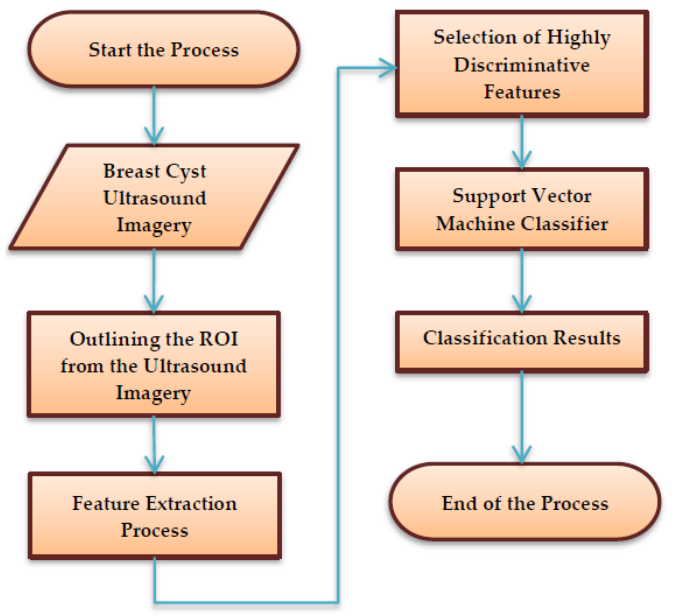
Figure 1. The schematic process flow diagram of the SVM (support vector machine)-enabled intelligent genetic algorithmic model.